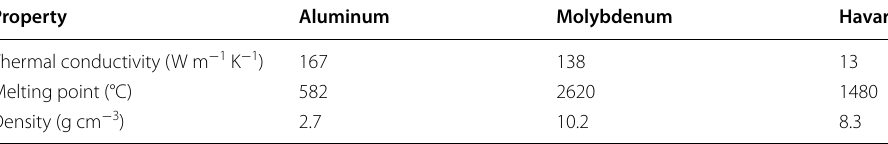
Table 3 The energy degrading foils characteristics for Aluminum, Molybdenum and Havar